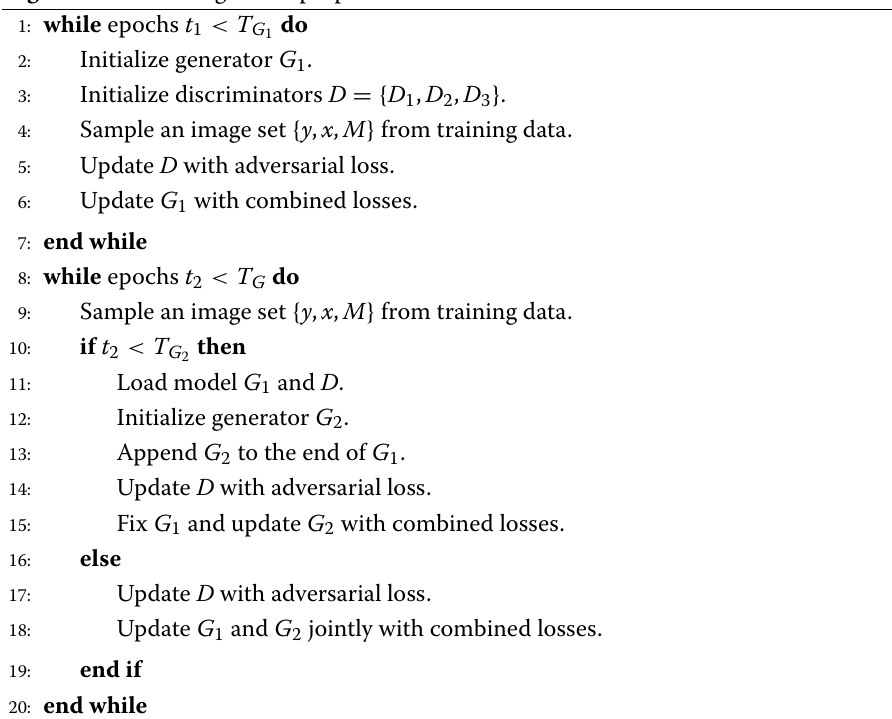
Algorithm 1 Training of our proposed